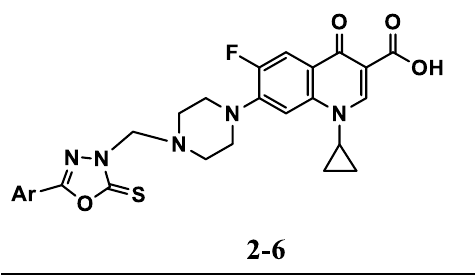
Table 2. Antimicrobial activities of compounds 2–6 .